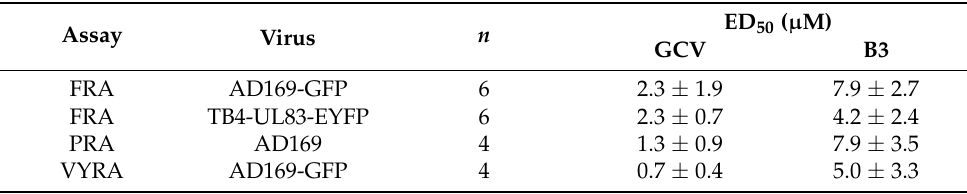
Table 2. Summary of ED 50 values calculated for GCV and B3 in this study. Assay Virus